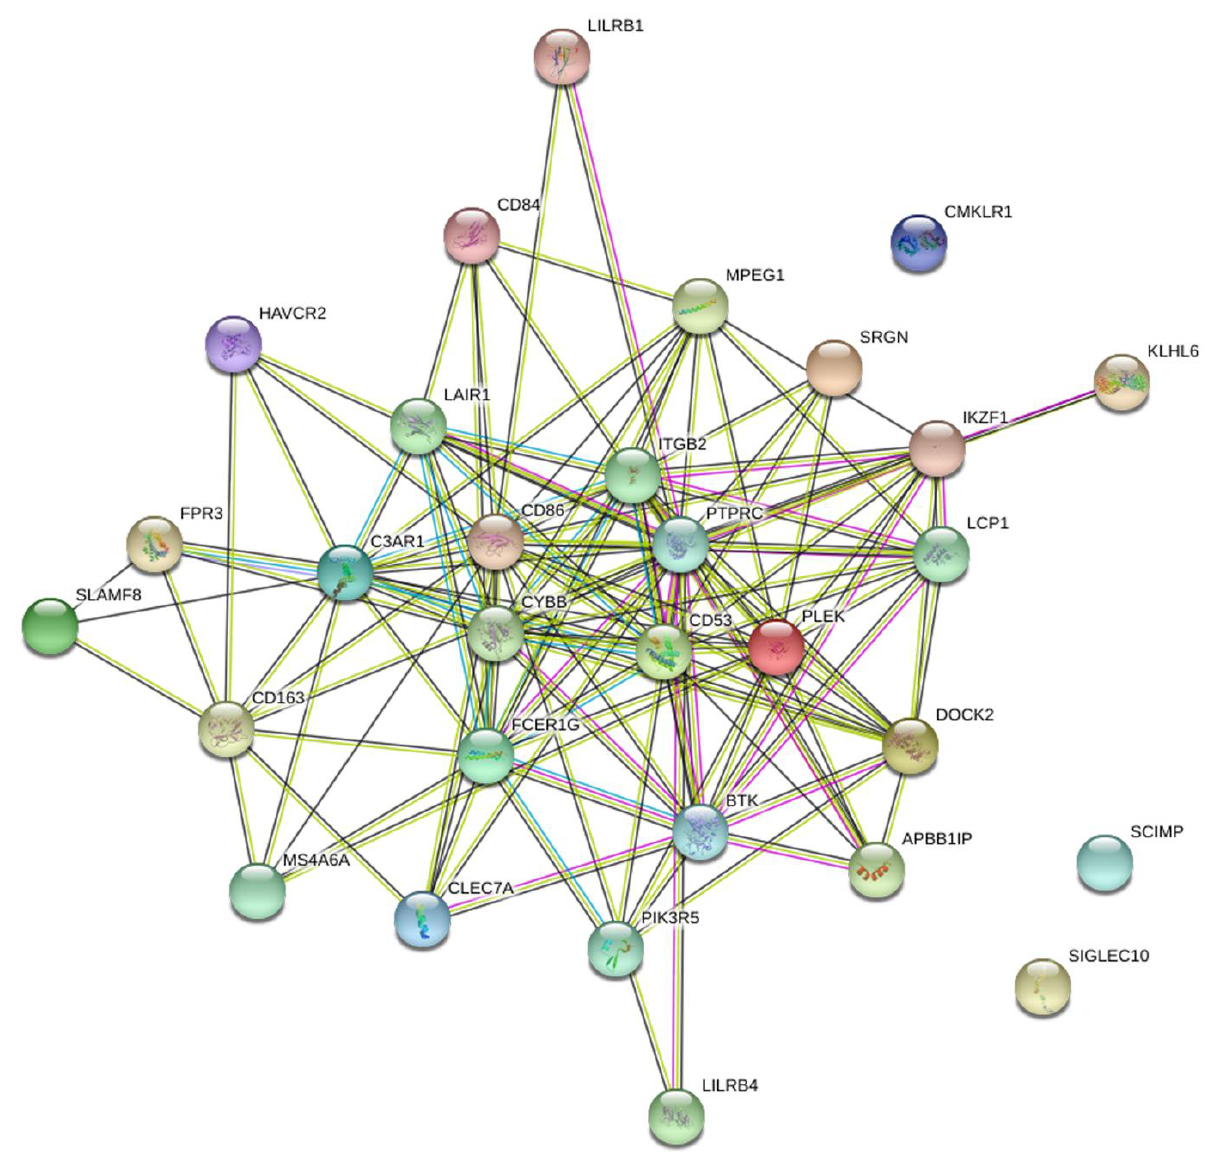
Figure 5. Network of PPI (protein–protein interaction). Genes within the black module were mapped using the PPI network.